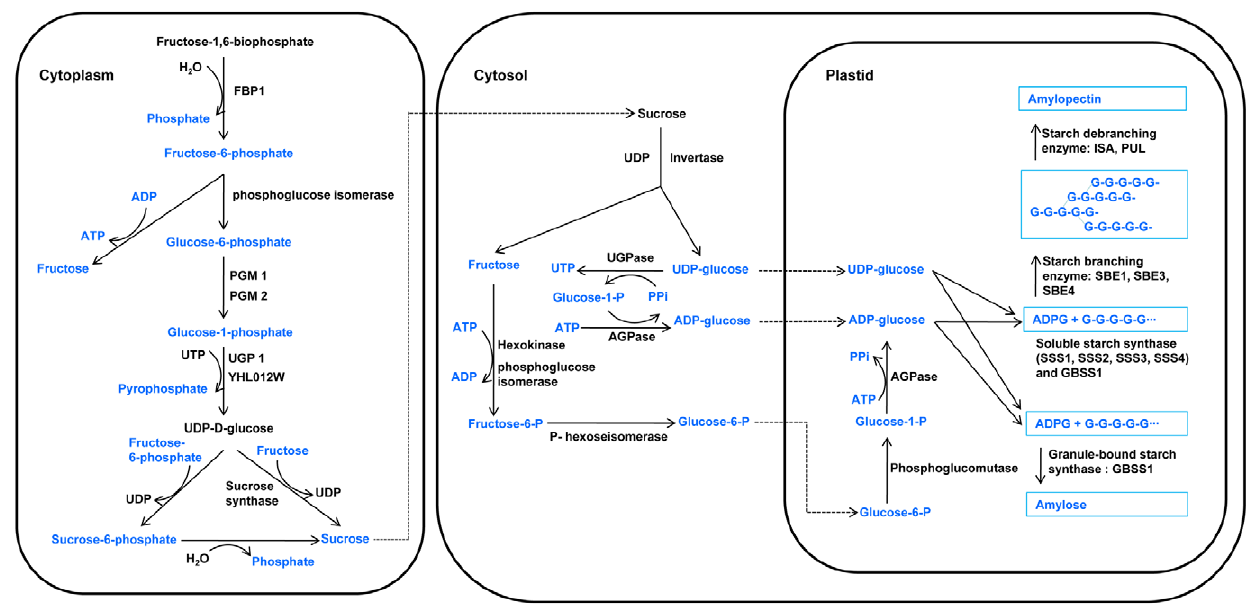
Figure 1. Main pathway of starch biosynthesis including sucrose synthesis, sucrose degradation and starch synthesis in rice. FBP1, fructose-1,6-bisphophatase1; PGM, phosphoglucomutase; AGPase, ADP-glucose pryophosphorylase; PPi, pyrophosphate.